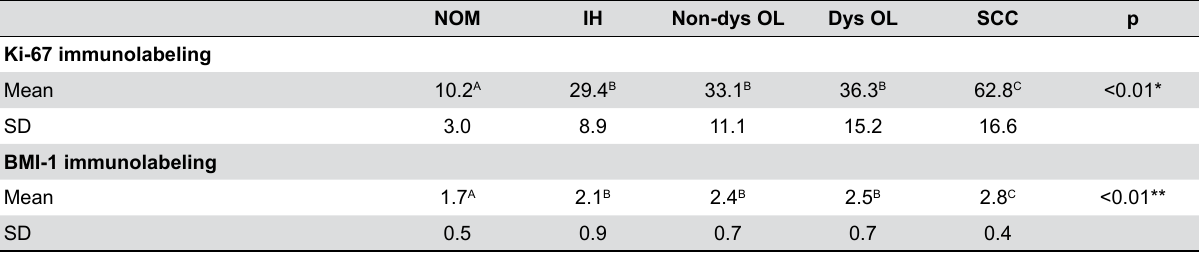
Figure 2- Gradual increase of Ki-67 and BMI-1 expression is observed from to normal oral mucosa (NOM) to oral squamous cell carcinoma (OSCC). Representative photomicrographs of NOM, inflammatory hyperplasia (IH), non-dysplastic oral leukoplakia (Non-dys OL), dysplastic oral leukoplakia (Dys OL) and OSCC. Original magnification ×400 Table 3- Percentage of immunopositive cells for Ki-67 and BMI-1 in normal oral mucosa (NOM), inflammatory hyperplasia (IH), and oral leukoplakia